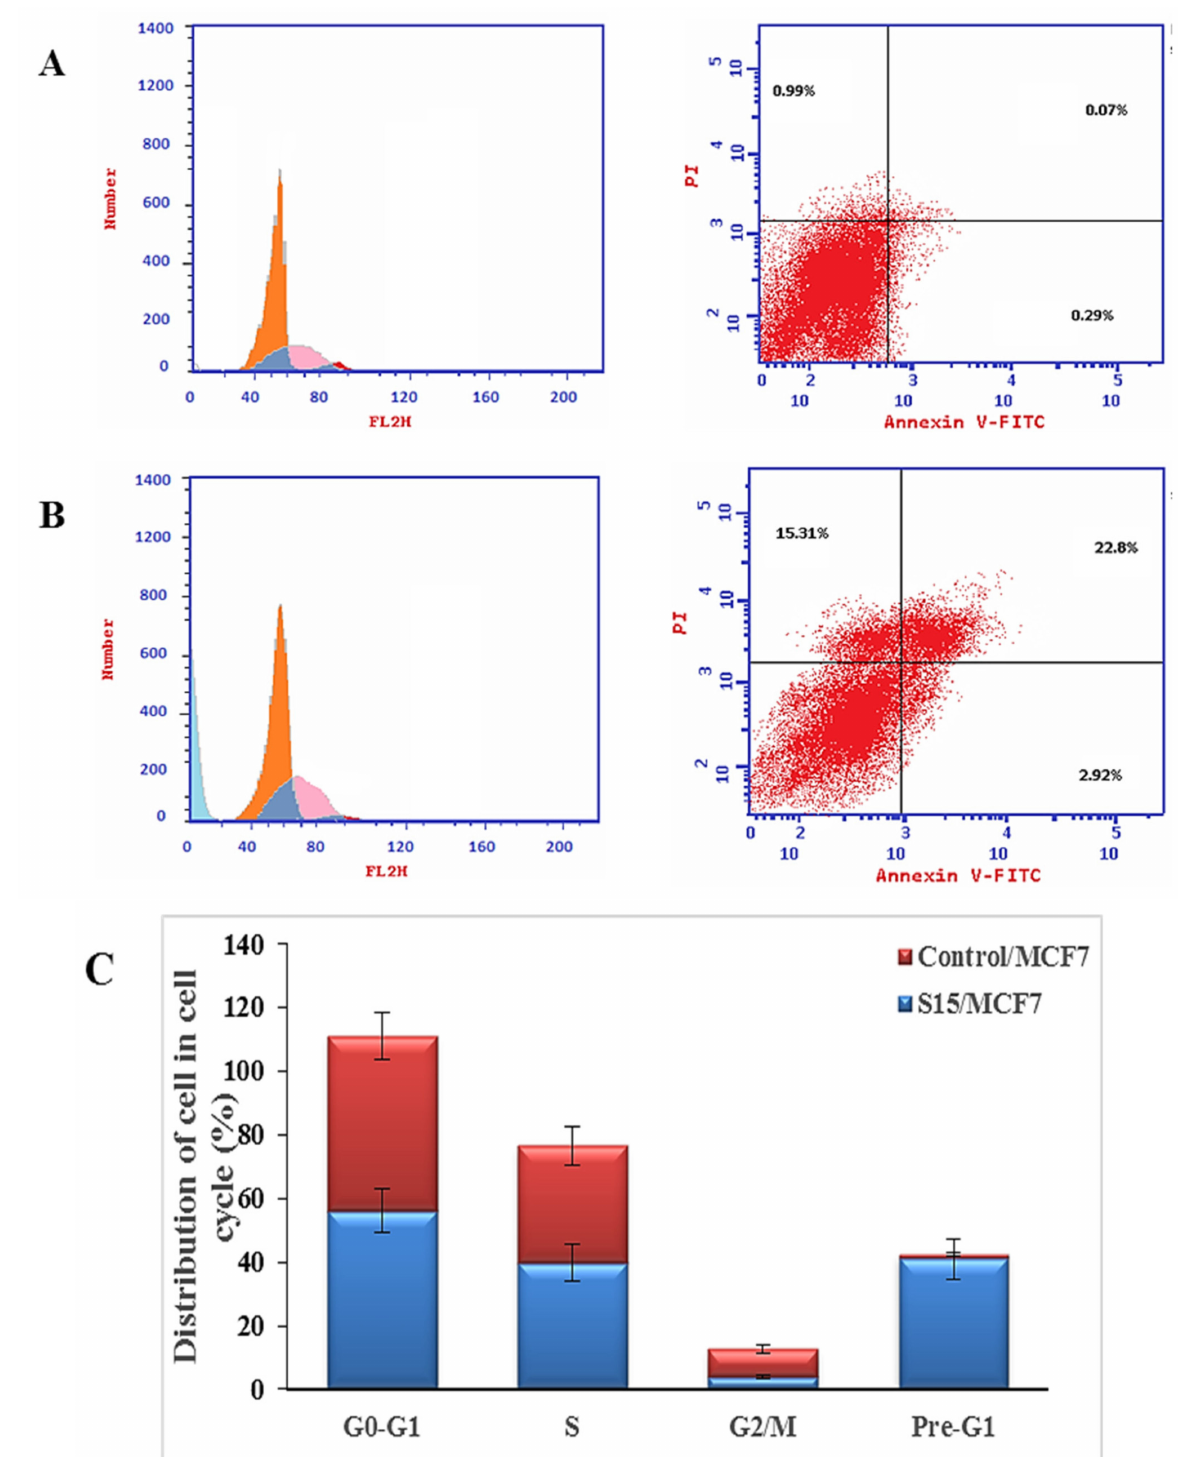
Figure 5. Percentage apoptosis and necrosis of MCF without treatment ( A ) or with S15 treatment ( B ) on Effect of Compound S15 on cell cycle distribution. Results were collected analyzed and blotted ( C ). The cells were treated with IC 50 ( µ M) of compound S15 and the cells were harvested and exposed to the analysis of cell-cycle. Data expressed as mean ±